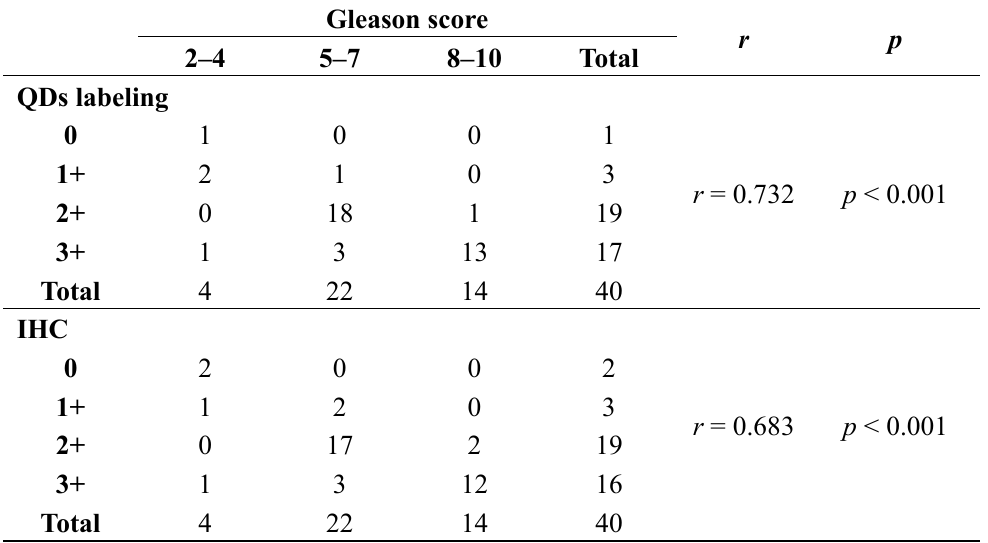
Table 1. Associativity analysis of PSCA expression levels and Gleason score in PCa by two